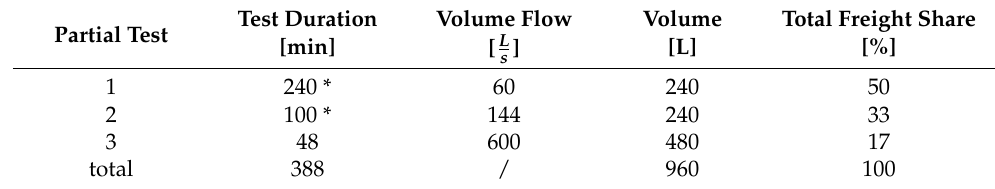
Table 4. Partial tests 1 – 3 for miniature shaft.